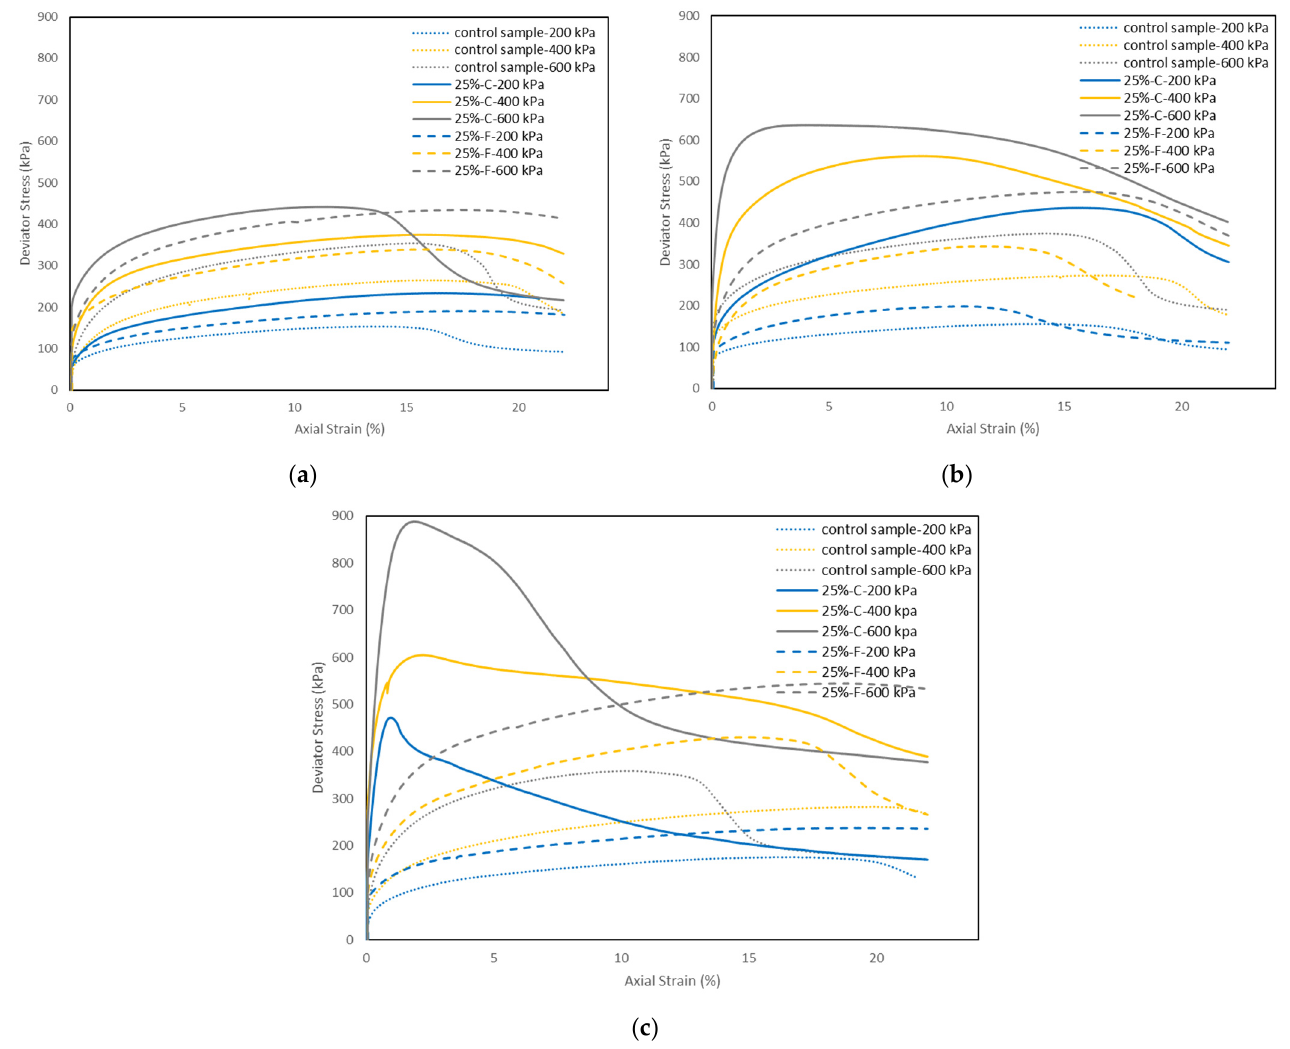
Figure 9. Stress-strain behavior of control sample and soil samples stabilized with 25% of class C and class F fly ash at confining pressures of 200, 400, and 600 kPa at ( a ) one day of curing, ( b ) seven days of curing, ( c ) 28 days of curing.